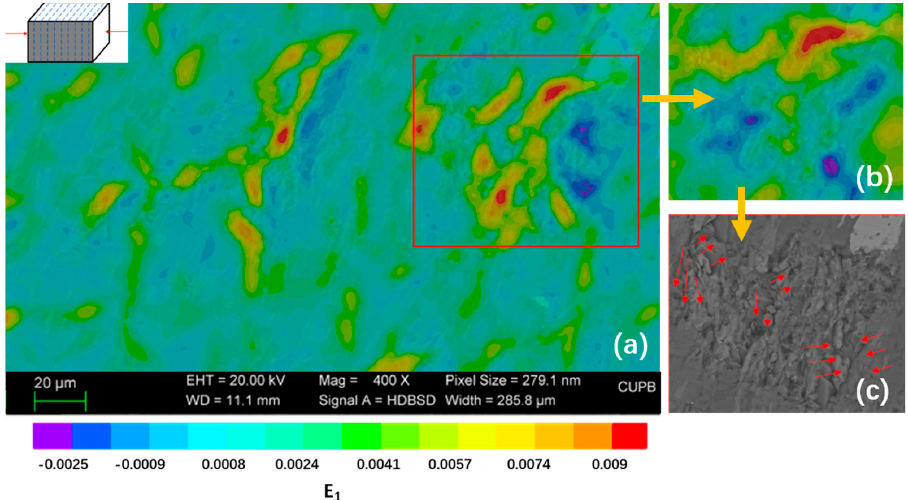
Figure 5. Microstructure deformation when the bedding angle is 60°: ( a ) E 1 cloud chart; ( b ) Zoomed- in microcracks in the circled region.